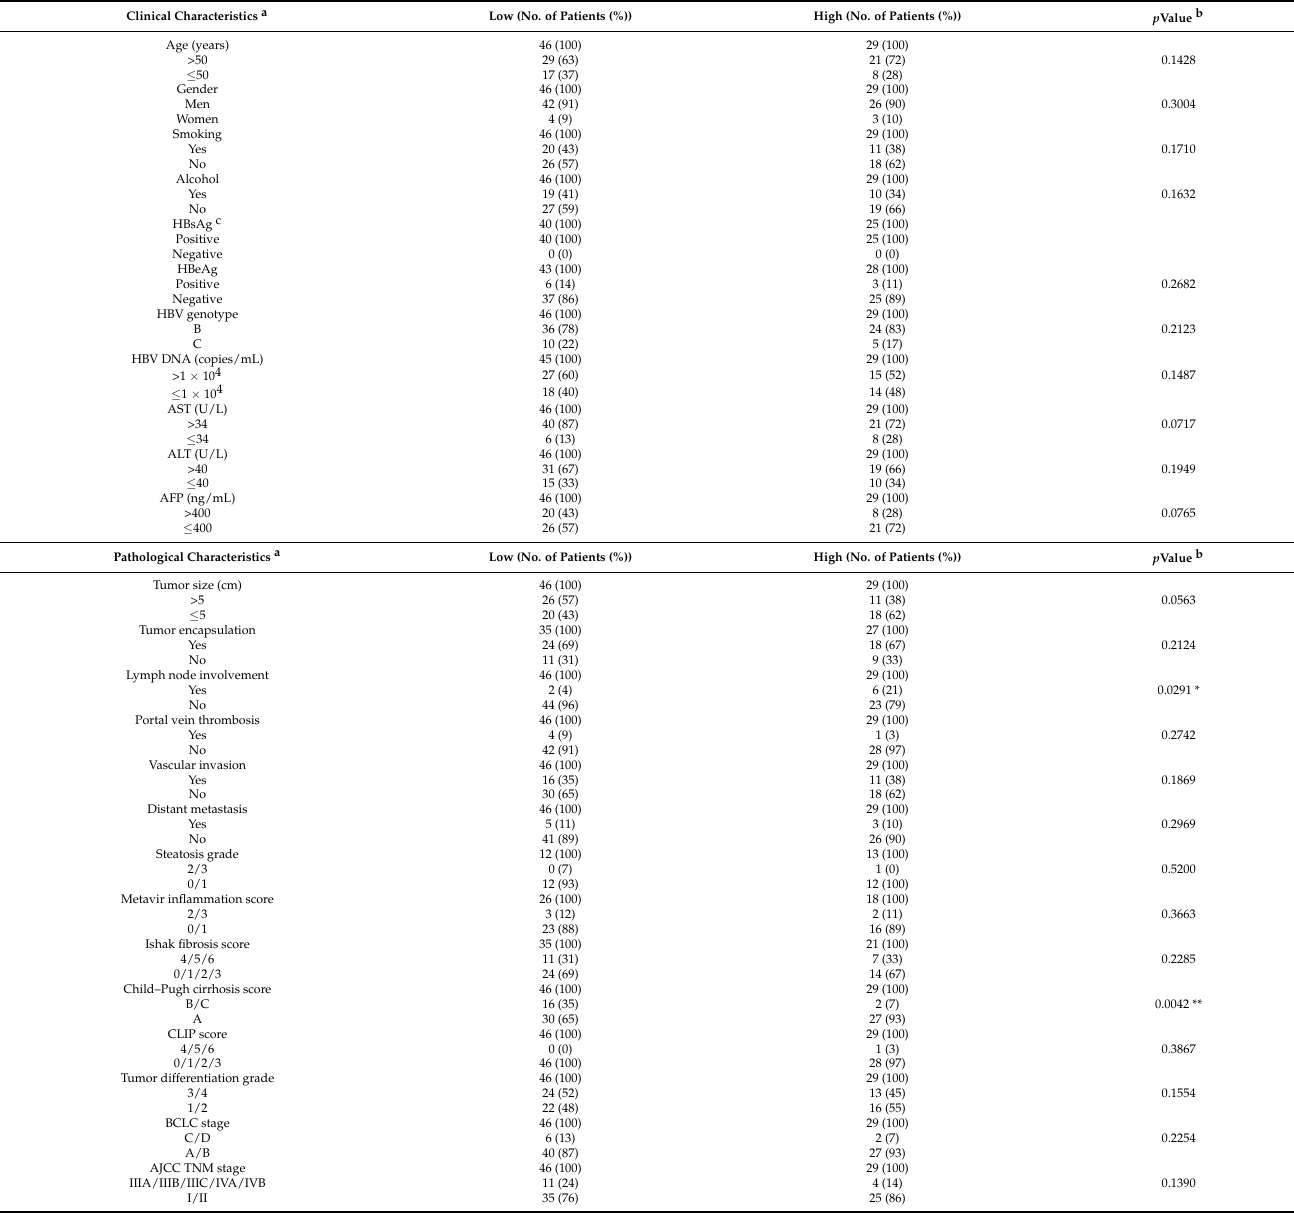
Table 4. Clinicopathological correlation of serum albumin level in 75 HBV-related HCC patients. ClinicalCharacteristicsa Low(No. ofPatients(%)) High(No. ofPatients(%)) p Valueb Age(years)